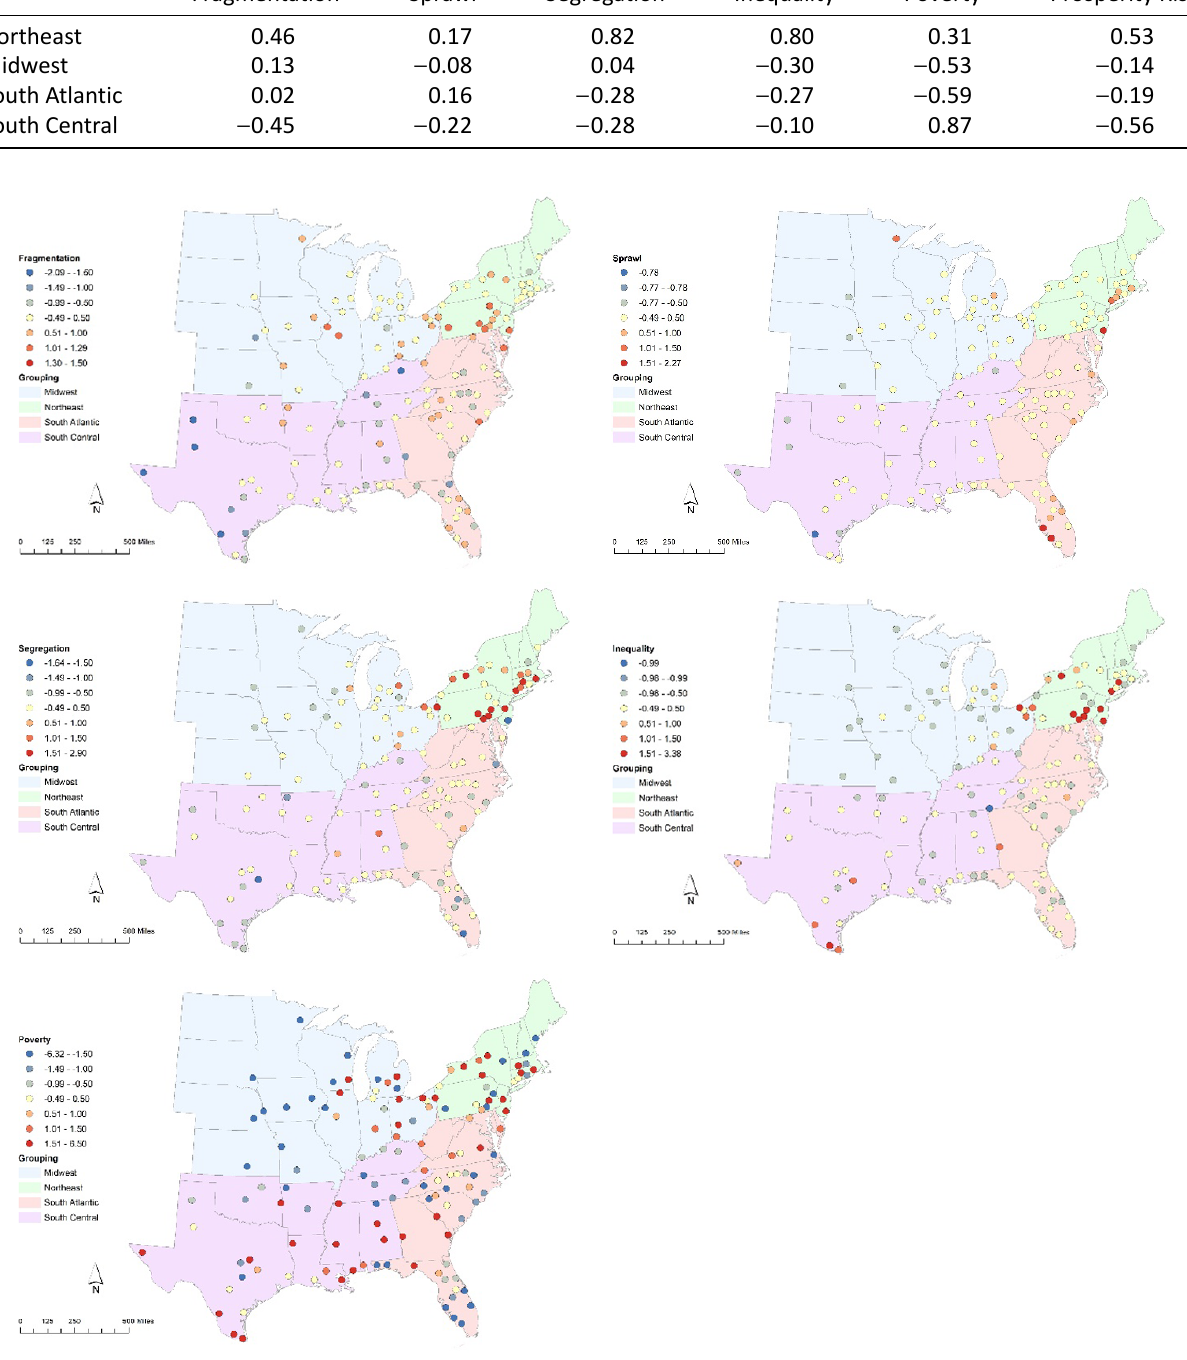
Figure 2. PRIMED characteristic z-scores for each urban